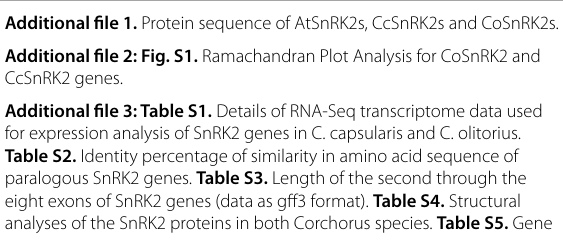
Table S2. Identity percentage of similarity in amino acid sequence of paralogous SnRK2 genes. Table S3. Length of the second through the eight exons of SnRK2 genes (data as gff3 format). Table S4. Structural analyses of the SnRK2 proteins in both Corchorus species. Table S5.